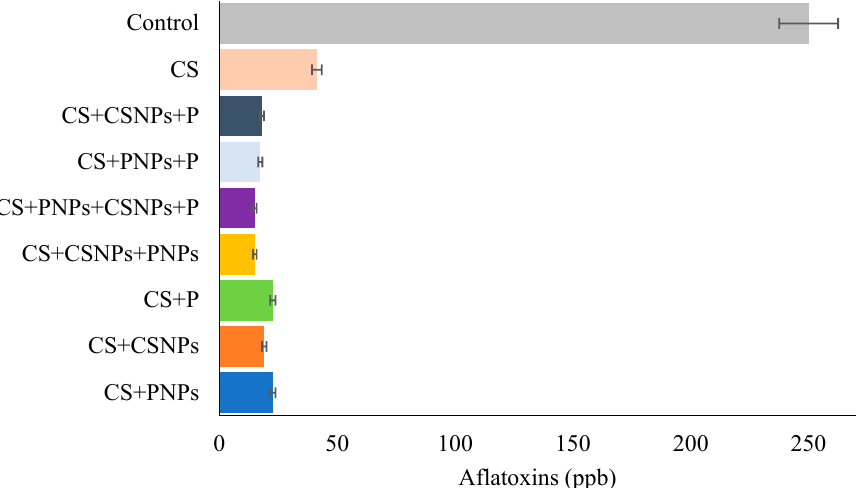
Figure 4. Effect of edible of chitosan/propolis on the aflatoxins production of A. flavus in fig fruit stored for 15 days at 4 °C.